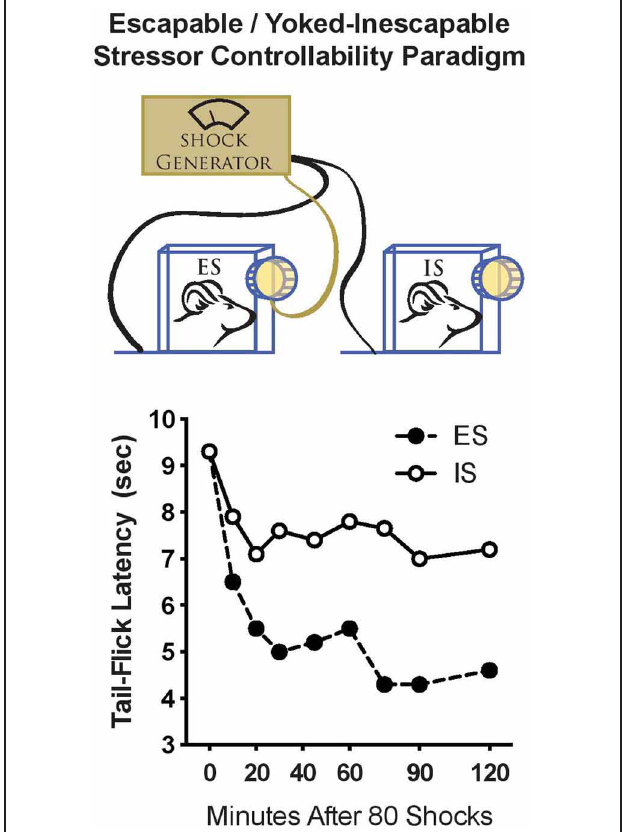
FIGURE 1 | Stressor controllability and resilience to tailshock. Top: A schematic diagram of the stressor controllability experiment. Rats are assigned to either escapable stress (ES), inescapable stress (IS), or no stress. Rats in the ES group receive a series (usually 80–100 trials) of tailshocks while restrained in a chamber with a wheel that is connected to a controlling computer. Rats in the ES group may escape from shocks by turning the wheel. Rats in the IS group are “yoked” to the ES rat such that shock is terminated for the IS when the wheel turn response is made. The wheel in the IS chamber is not connected to the computer, so these rats do not have control over shock onset or offset. Importantly, each rat in the pair receives exactly equal tailshock. Bottom: Stressor controllability and analgesia. Rats were exposed to 80 trials of ES or IS, and pain tolerance was quantified using the tail-flick reflex to heat applied to the tail at various times after stress. Both ES and IS rats displayed analgesia immediately after stress. However, analgesia persisted for 2h after IS while ES rats recovered (adapted from Drugan et al., 1985a).